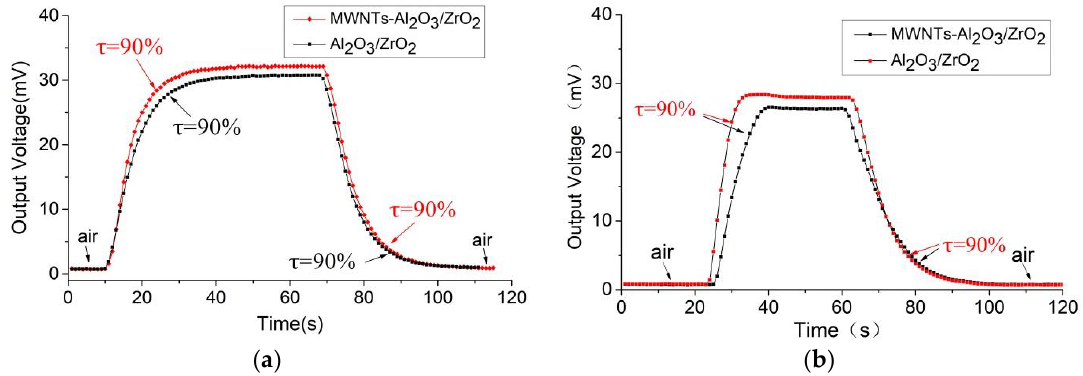
Figure 10. Response-recovery curves of different sensors for a methane concentration of 20%. Two powder metallurgy packaging materials are shown: ( a ) a 400-mesh package, and ( b ) a 200-mesh package.